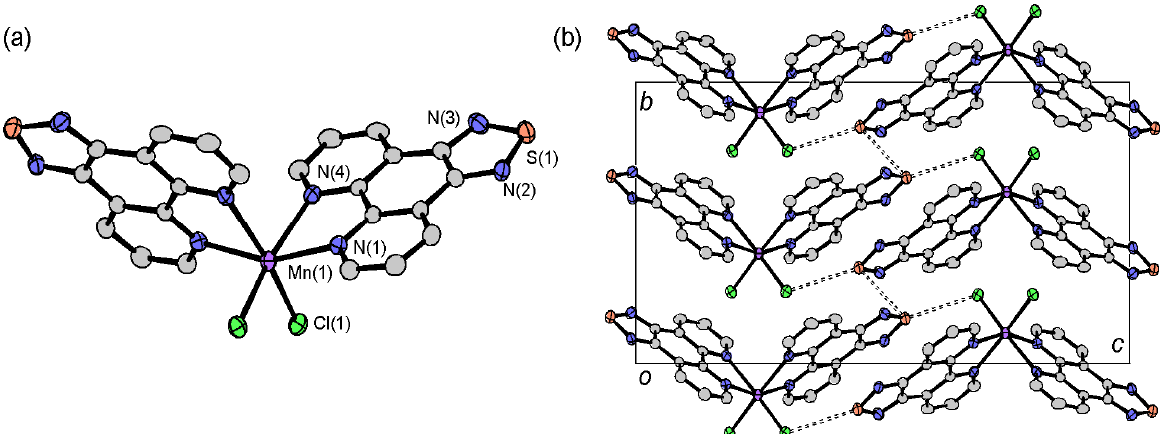
Figure 7. Molecular structure ( a ) and crystal packing ( b ) of [Mn(tdap)